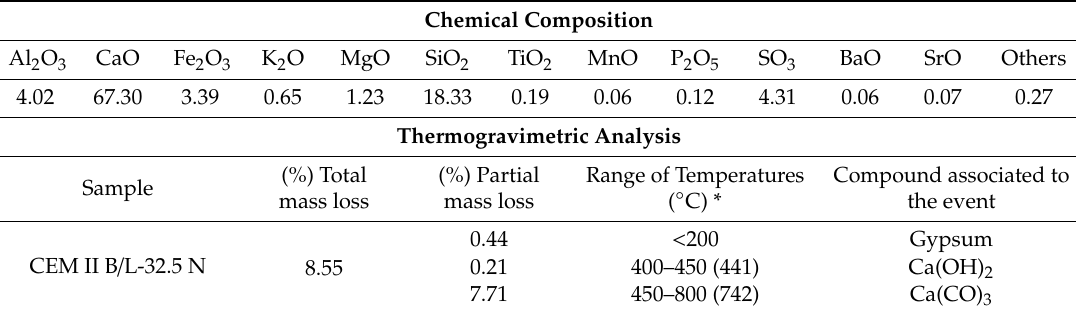
Table 2. Characteristics of the type CEM II B / L-32.5 N cement used.